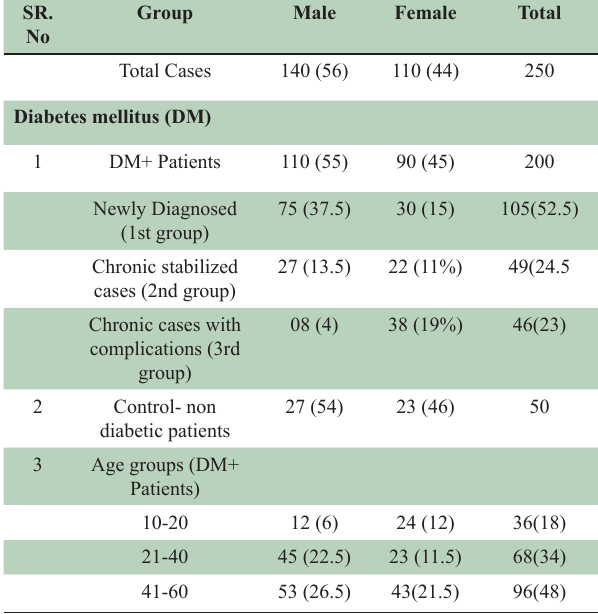
Table-I: Gender distribution of all the study groups.